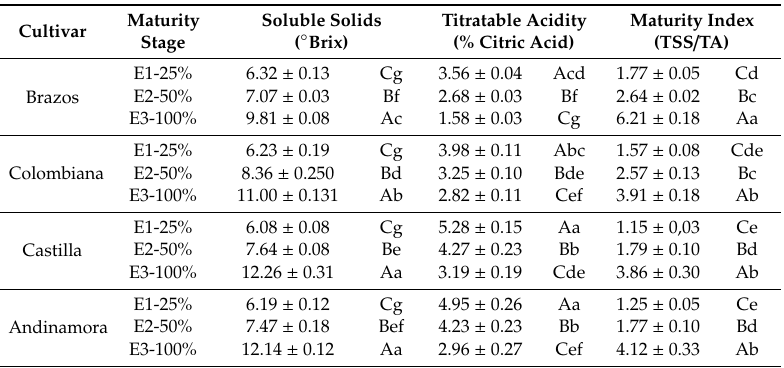
Table 2. Physicochemical analysis of four blackberry cultivars. Maturity Soluble Solids Titratable Acidity Cultivar Stage ( ◦ Brix) (% Citric